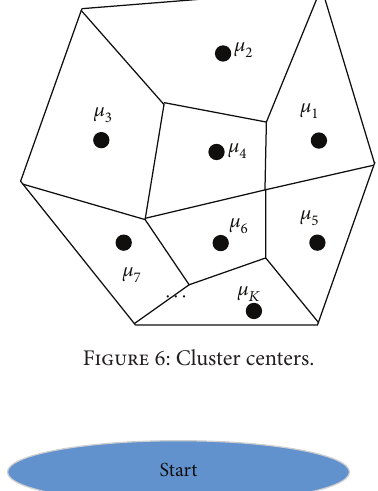
Figure 6: Cluster centers.